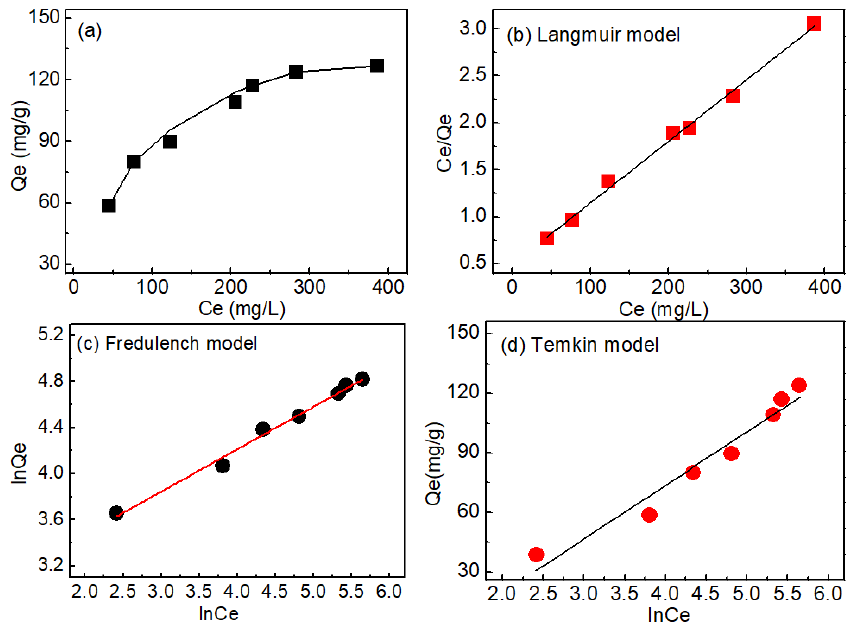
Figure 9. Equilibrium studies of phosphate adsorption: relation of the adsorption capacity with the equilibrium concentration ( a ); Langmuir isotherm model ( b ); Freundlich isotherm model ( c ) and Tekmin isotherm model ( d ). Table 2. Langmuir, Freundlich, Tekmin isotherm model parameters and correlation coefficients for the adsorption of phosphate.